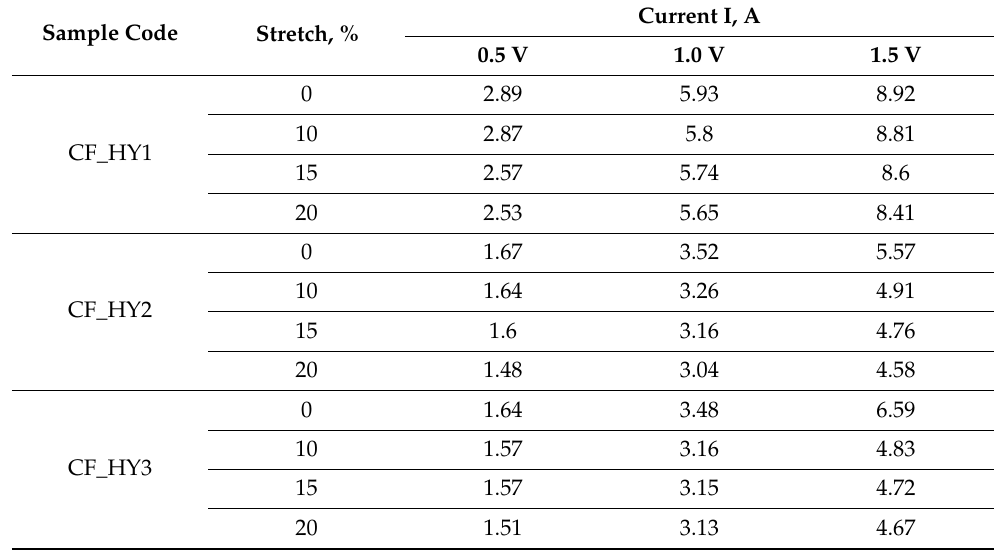
Table 3. Influence of stretching on the current I generated in CF_HY1, CF_HY2 and CF_HY3 during employing different voltage